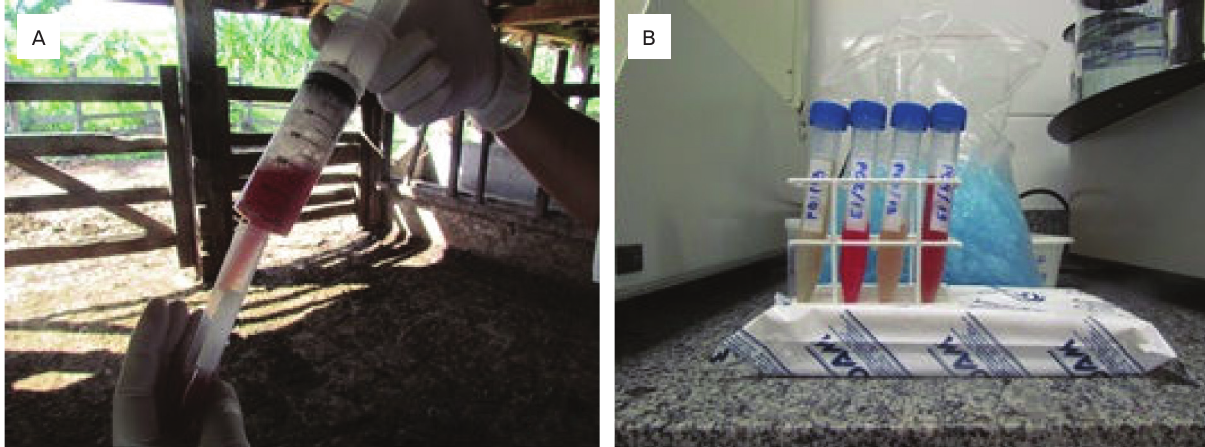
Figura 3. Recuperação do lavado vesical do grupo B. (A) Recuperação do último volume aspirado do lavado; (B) amostras armazenadas em tubos plásticos tipo Falcon com capacidade de 15 mL, devidamente identifi